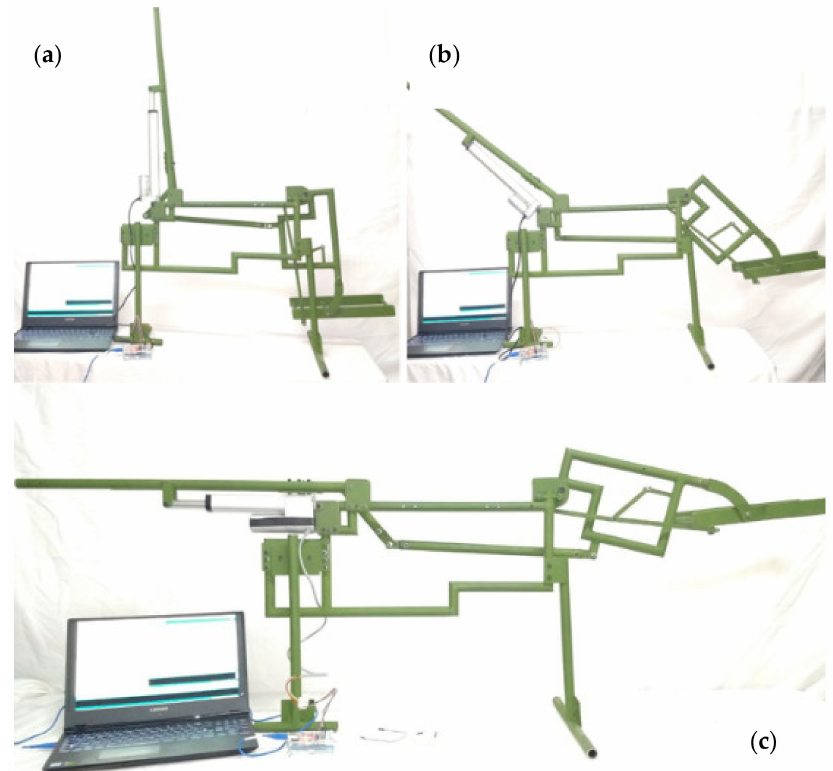
Figure 15. Experimental wheelchair test, ( a ) Wheelchair seat position ( b ) Wheelchair middle position ( c ) Wheelchair stretcher